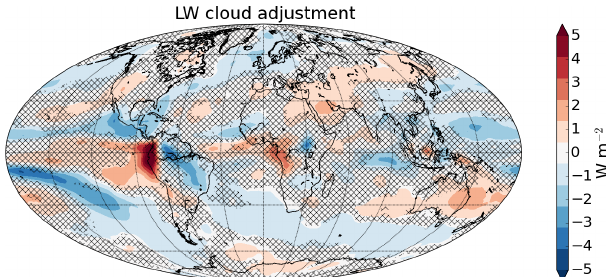
Figure 9. Multi-model mean change in LW cloud radiative effect in G1 – piControl, corrected for cloud masking of LW air temperature, surface temperature, and water vapor adjustments and CO 2 forcing. Positive values indicate a decrease in OLR, i.e., a warming effect. Hatching indicates areas where fewer than 9 of 11 models agree on the sign of the